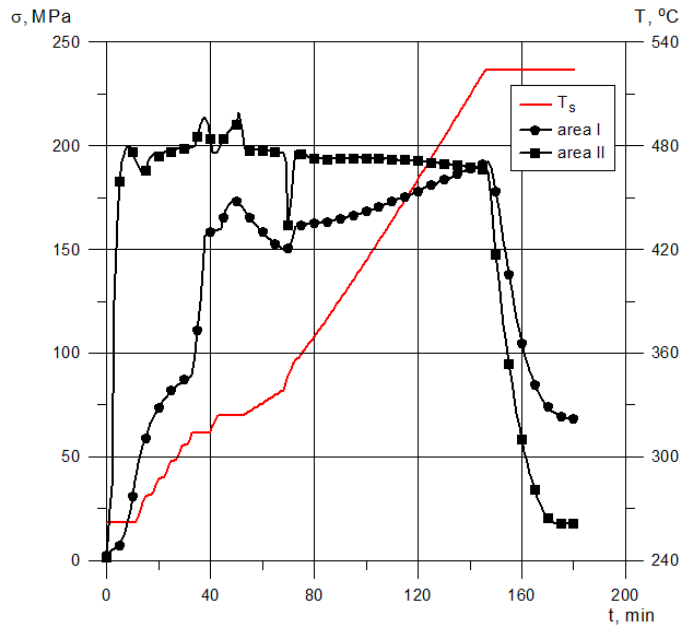
Figure 9. The course of stresses in critical areas and steam temperature after applying the stress control algorithm for 𝜎 𝑝𝑒𝑟𝐼𝐼 = 210 MPa . control algorithm for σ perII = 210